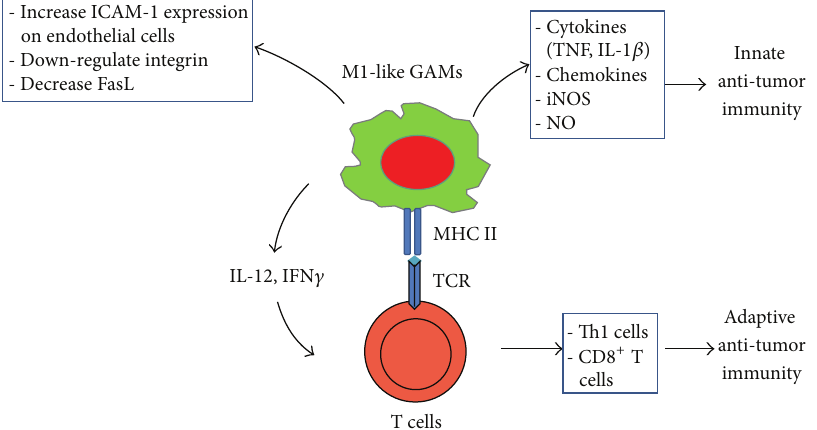
Figure 3: Glioma-associated microglia/macrophages (GAMs) have anti-tumoral potential. In certain circumstances, GAMs can be activated and polarized to a M1-like phenotype that can contribute to both innate and adaptive anti-tumor immunity.